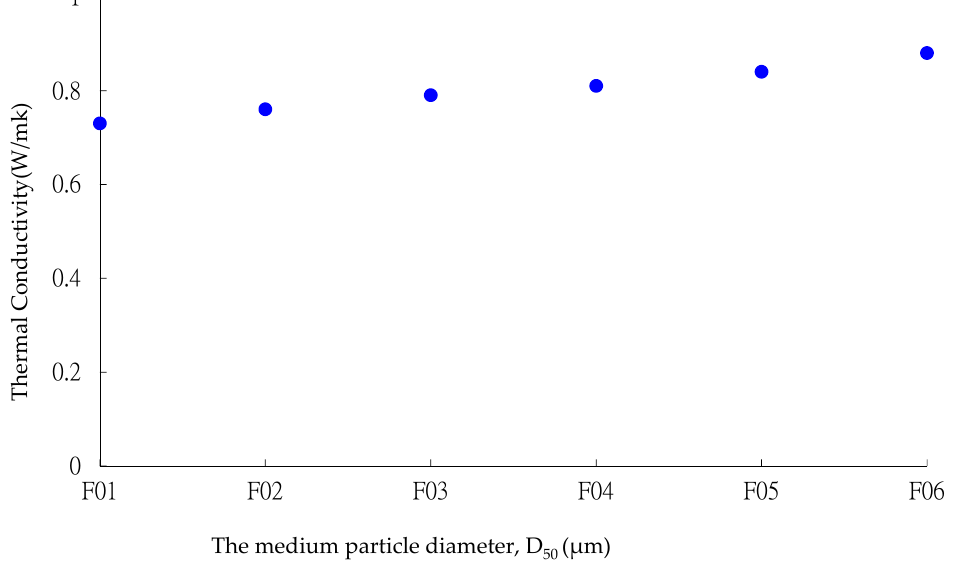
Figure 6. Thermal conductivities of EMCs with polygonal fused silica versus D50 ( σ : 0.005 W/mK–0.008 W/mK).